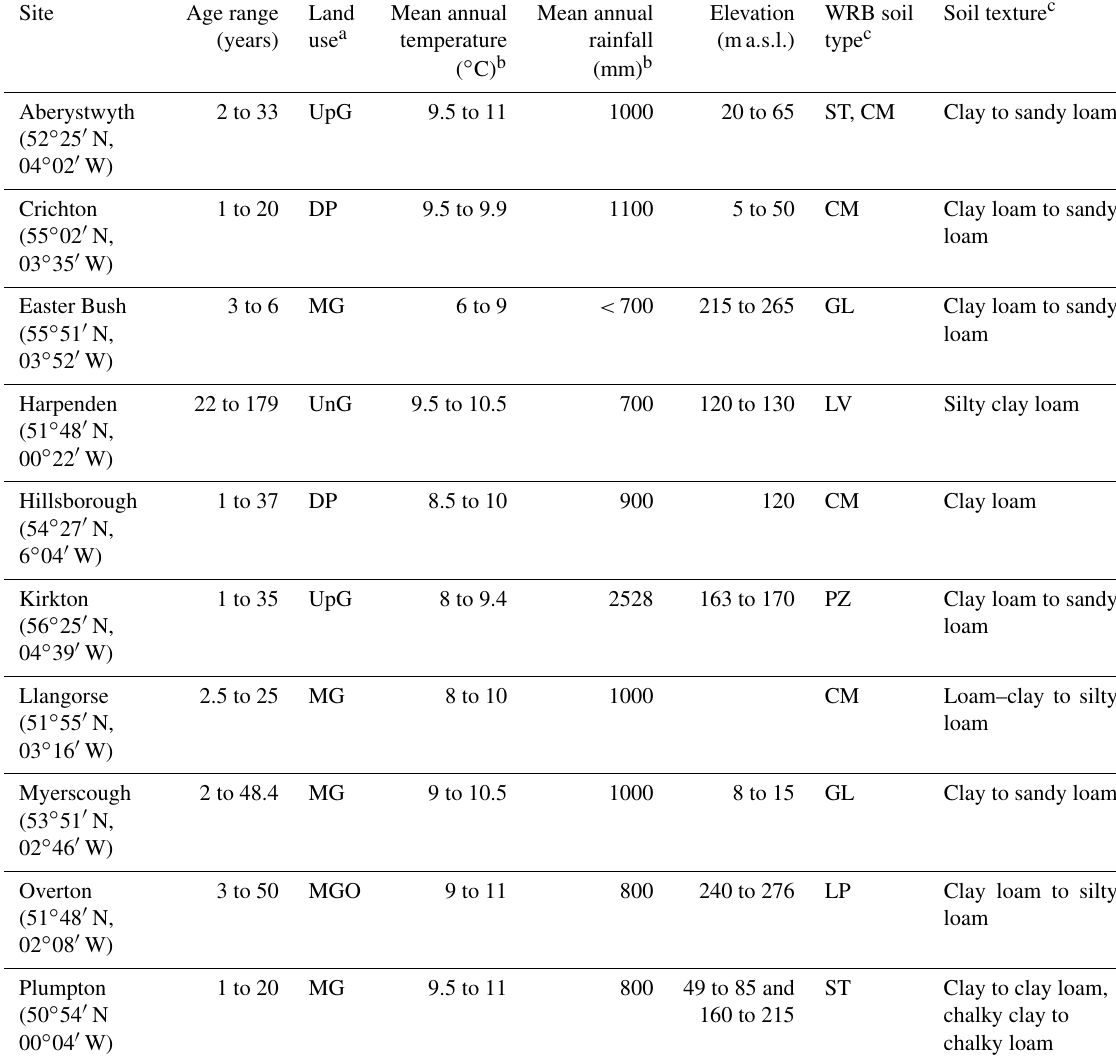
Table 1. Summary of UK grassland site